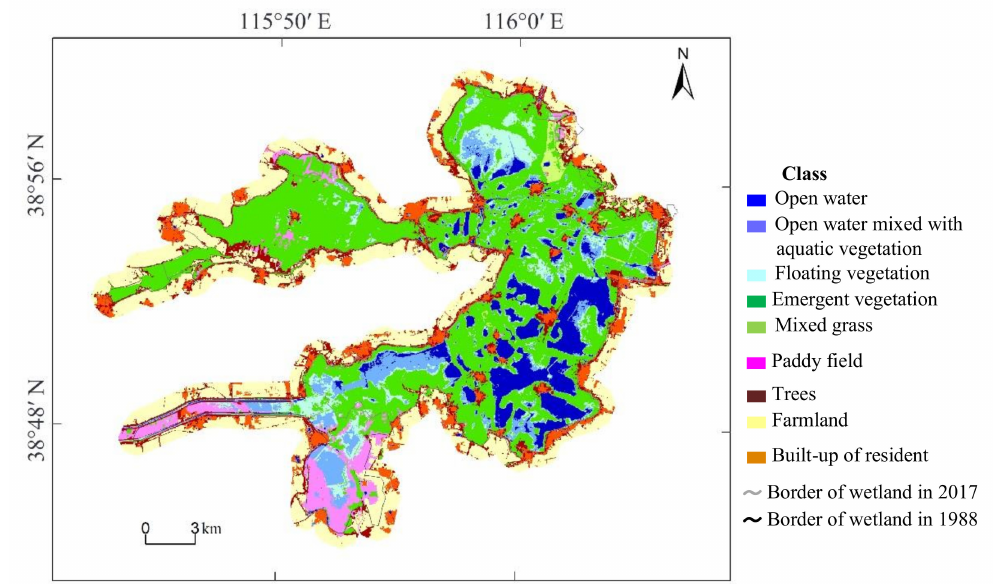
Figure 8. The classes of wetland habitats in the first phase derived from the clustering of NDVI time-series data from 1988 to 1999.